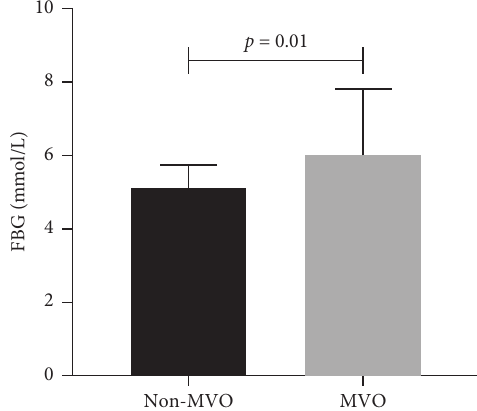
Figure 2: Fasting blood glucose in non-microvascular obstruction and microvascular obstruction groups. FBG, fasting blood glucose; MVO, microvascular